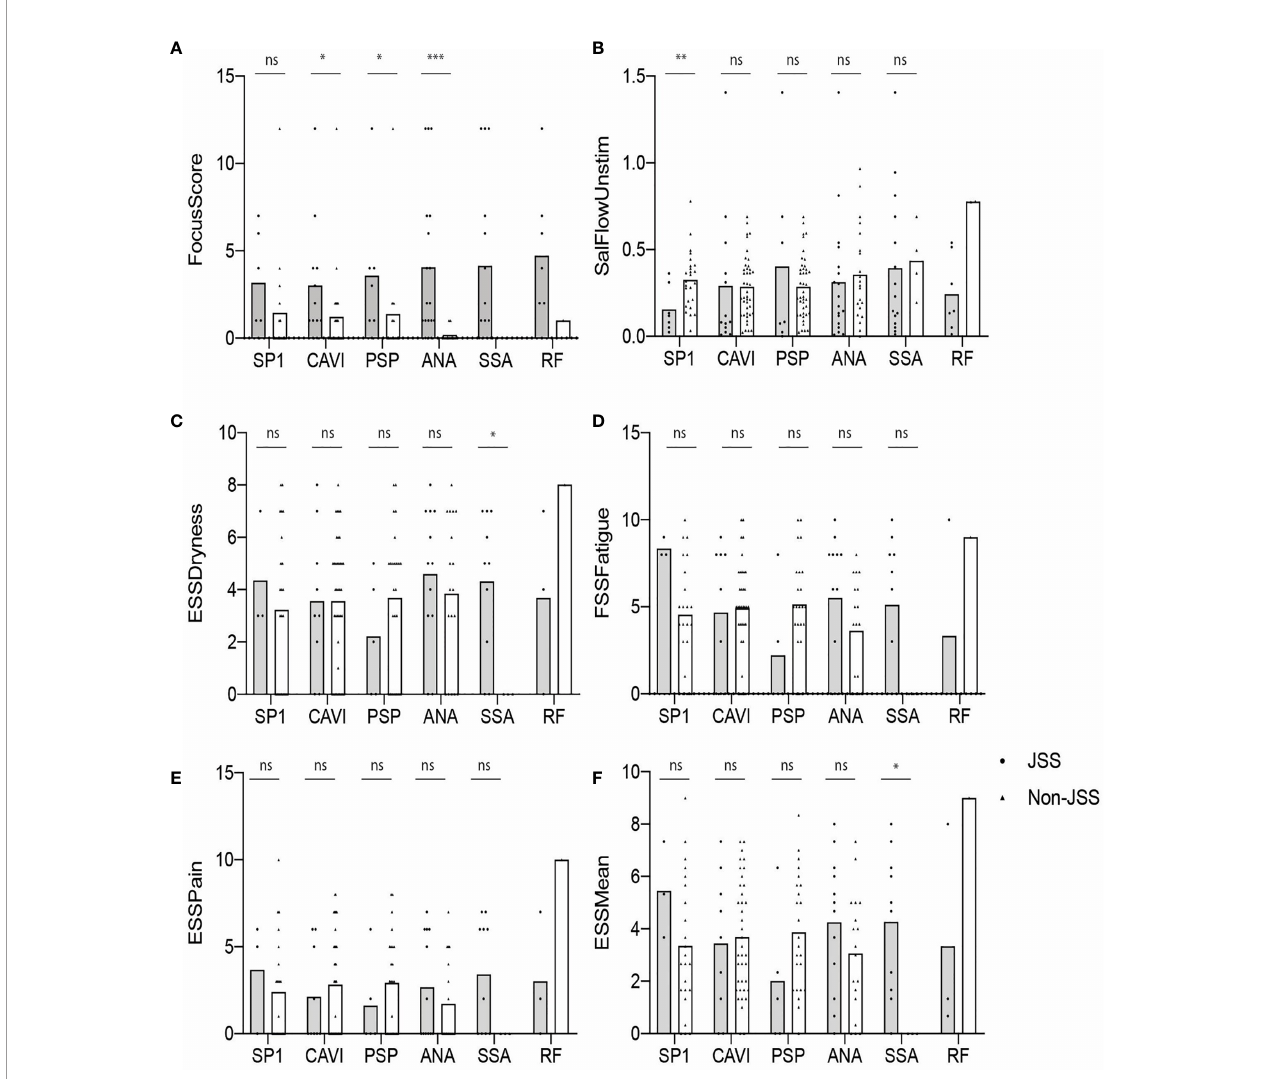
FIGURE 2 | Autoantibody-positive JSS and non-JSS plotted for objective and subjective parameters (A – F) . The statistical signi fi cance is displayed above the bracket of each bar. The brackets were not depicted and p-values were not calculated when the sample number was below 3 in either group. Each dot depicts actual value of the parameter for each subject. Gray bar, JSS; white bar, non-JSS; ns, not signi fi cant; *p ≤ 0.05; **p ≤ 0.01; ***p ≤